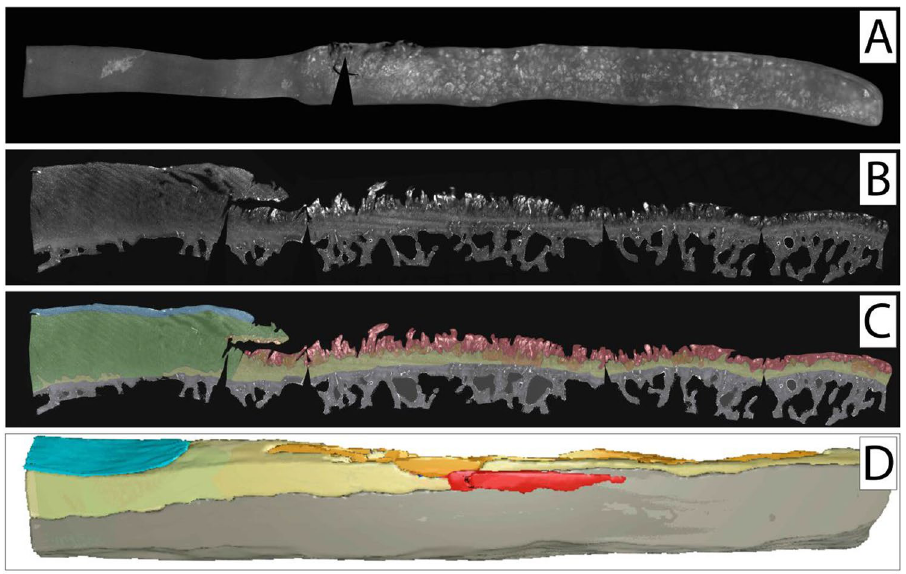
Figure 4. Top-down ( A ) and side view ( B , C ) of cartilage specimen II and the corresponding SR-µCT image rendering ( D ). ( C , D ) Zonal colour labelling of the predominant spatial chondrocyte arrangement: blue— superficial zone, green—single strings, yellow—double strings, orange—small clusters, red—large clusters, purple—diffuse, grey—subchondral bone. On the left side, in macroscopically intact cartilage, single strings are predominant in the deep zone underlying an intact superficial zone. On the right side, the eroded remaining cartilage shows large clusters in the defect area, with smaller clusters at the transition to the underlying double strings in the tide mark. Due to the thinned-out cartilage layer some subchondral bone had to be left in place to ensure the stability of the specimen. The black wedges are a digital artefact of straightening the image. This figure was created using MeVisLab (https:// www. mevis lab. de/ mevis lab), Adobe Photoshop CS6 (https:// www. adobe. com/ ch_ de/ produ cts/ photo shop. html) and Adobe Illustrator CS6 (https:// www. adobe. com/ ch_ de/ produ cts/ illus trator.